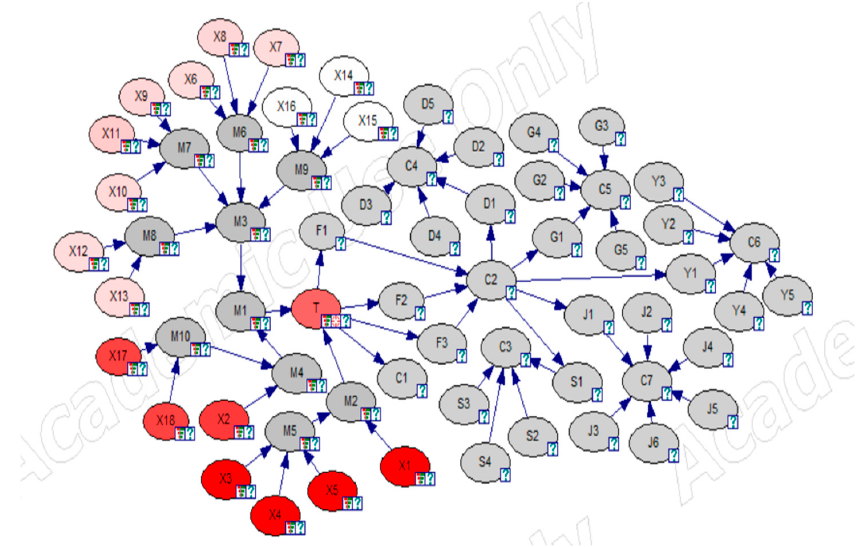
Figure 11. Node sensitivity analysis.